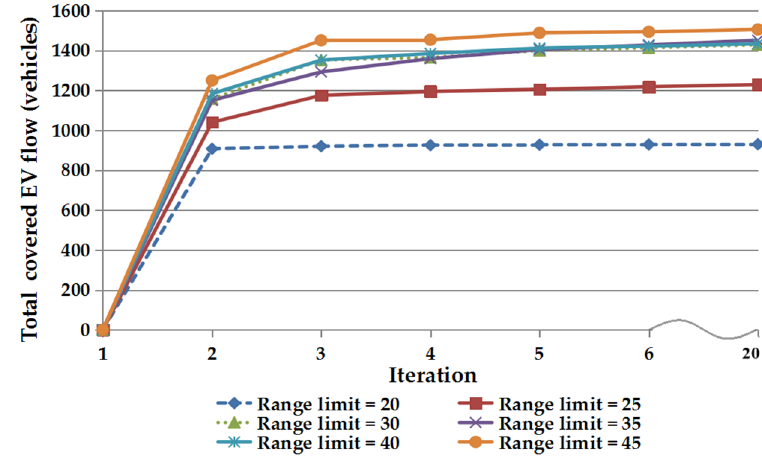
Figure 5. The sensitivity analysis of the range limit.